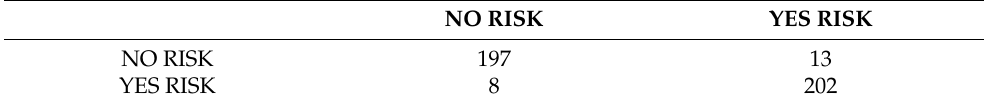
Table 6. Confusion matrix of the best algorithm in terms of evaluation metrics scores: the GB.